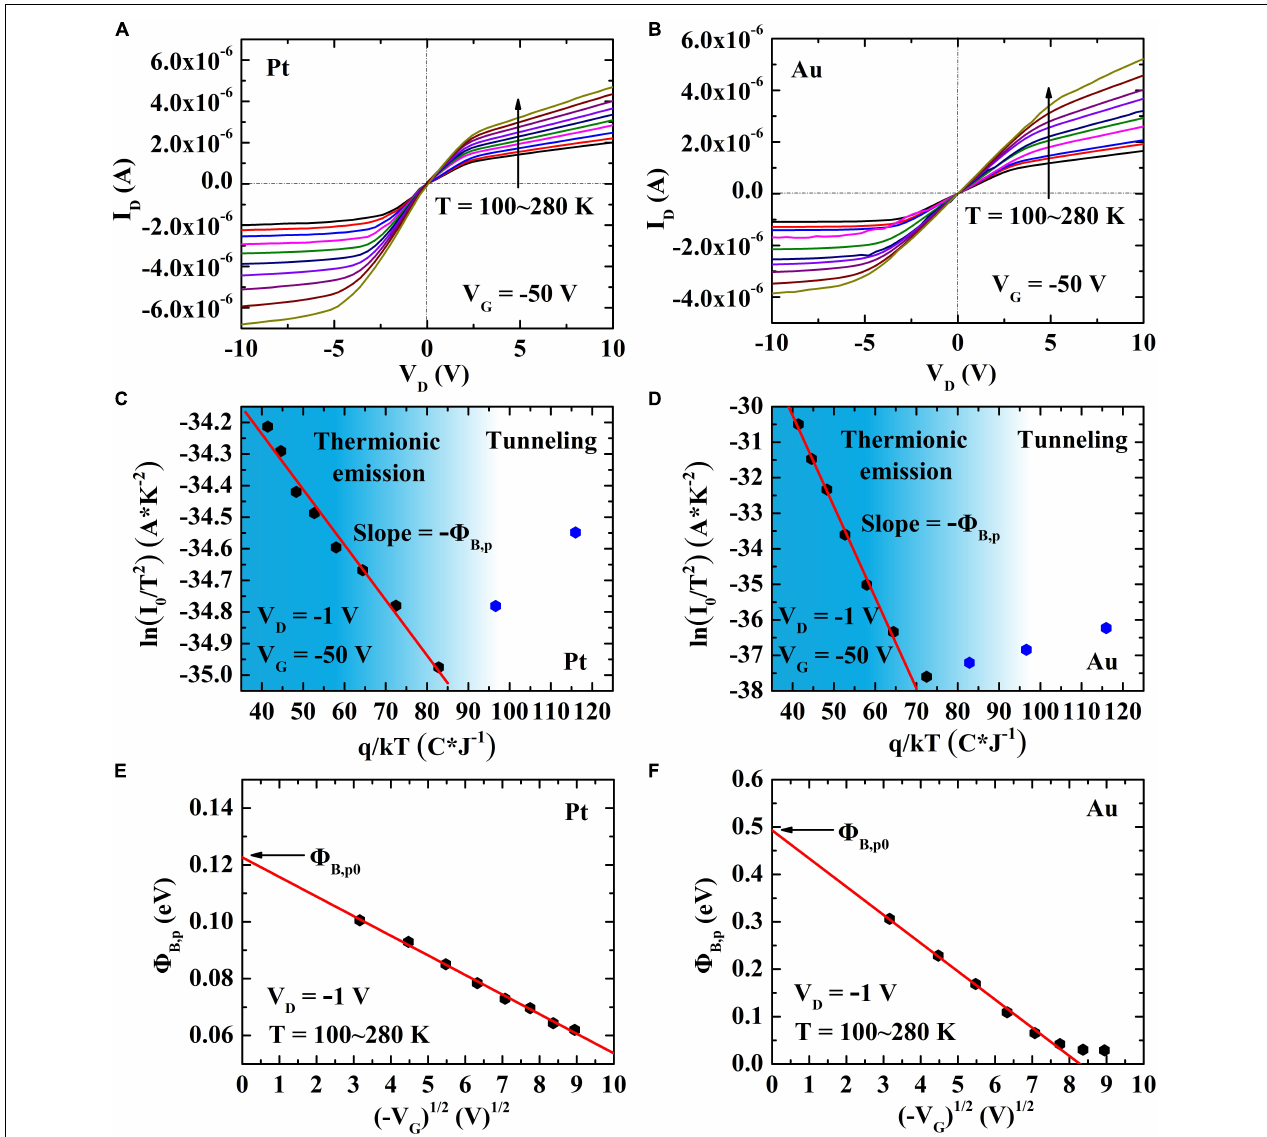
FIGURE 4 | Output characteristics of top-gated IDT-BT OFETs with (A) Pt and (B) Au contacts at the temperatures varying from 100 to 280 K; linear fit for the thermionic emission model for the devices with (C) Pt and (D) Au contacts. The Schottky barrier ( (cid:56) B ) is extracted from the slope of the linear fitting of ln( I 0 / T 2 ) versus ( q / kT ) curve; linear fit for the image-force barrier lowering arising from V G for the devices with (E) Pt and (F) Au contacts. An intrinsic barrier ( (cid:56) B , p 0 ) is obtained by the intercept at zero V G , where V D = − 1